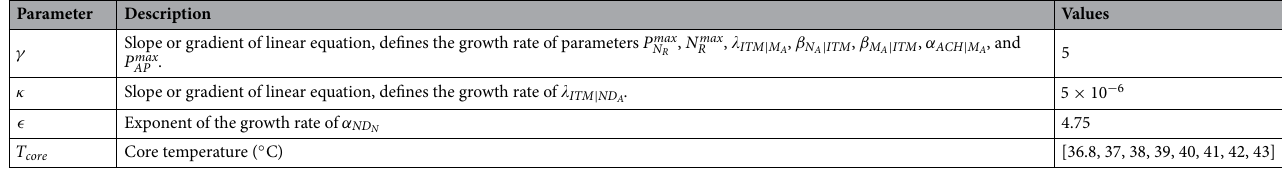
Table 1. Additional parameters used in the simulation of the HIIS response to increasing temperature, defined by Eqs. 1, 2, and